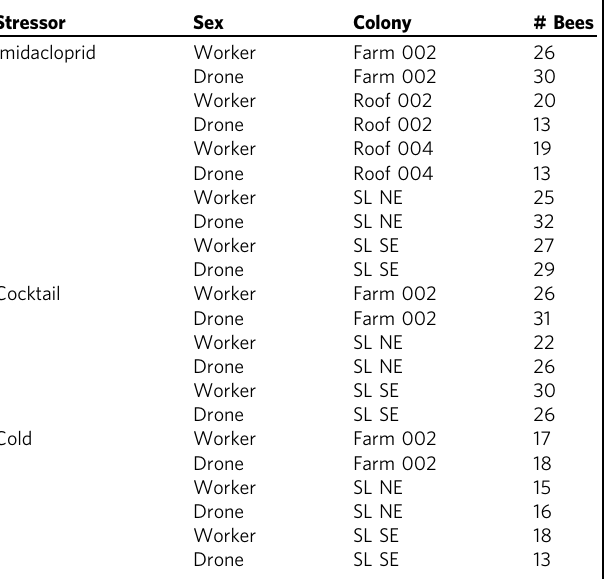
Table 1 Sample sizes and colony origins for drone and worker survival